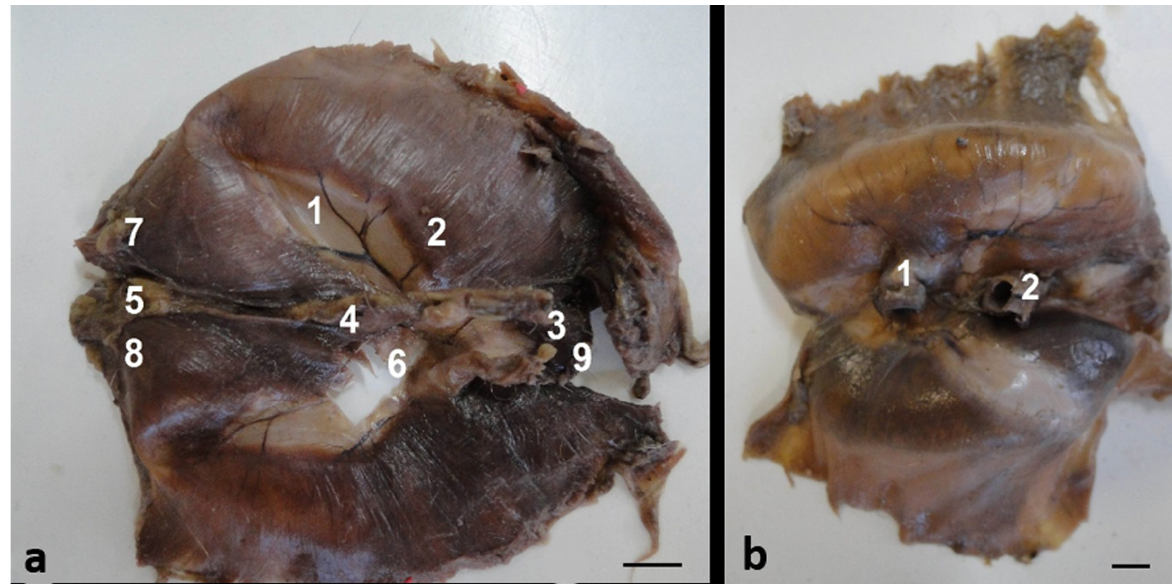
Figure 1 - Fotomacrography of abdominal face of the diaphragm of the Saimiri sciureus . a - tendinous center (1), part of the costal diaphragm dome (2), sternal part of the diaphragm dome (3), esophageal hiatus (4), aortic hiatus (5), foramen of the caudal vena cava (6), diaphragmatic pillars right (7), diaphragmatic pillars left (8) and xiphoidal process (9). b - Esophagus (1) and phrenicopericardic ligament (2). Scale bar: 1cm.